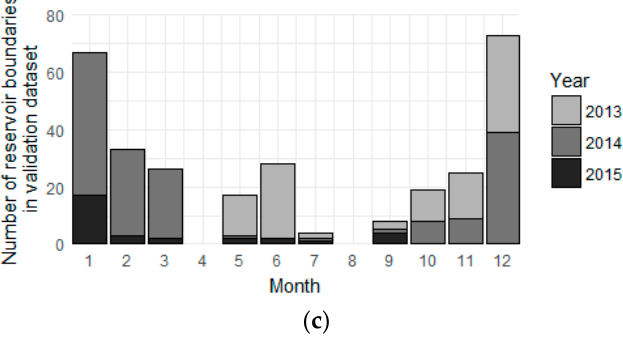
Figure A1. Google Earth derived reservoir areas data (n = 272), used as validation to assess accuracy of GSW and Landsat 8 OLI reservoir area estimates, distributed by ( a ) reservoir area, ( b ) reservoir latitude, ( c ) imagery month and year used to digitize reservoir boundary.